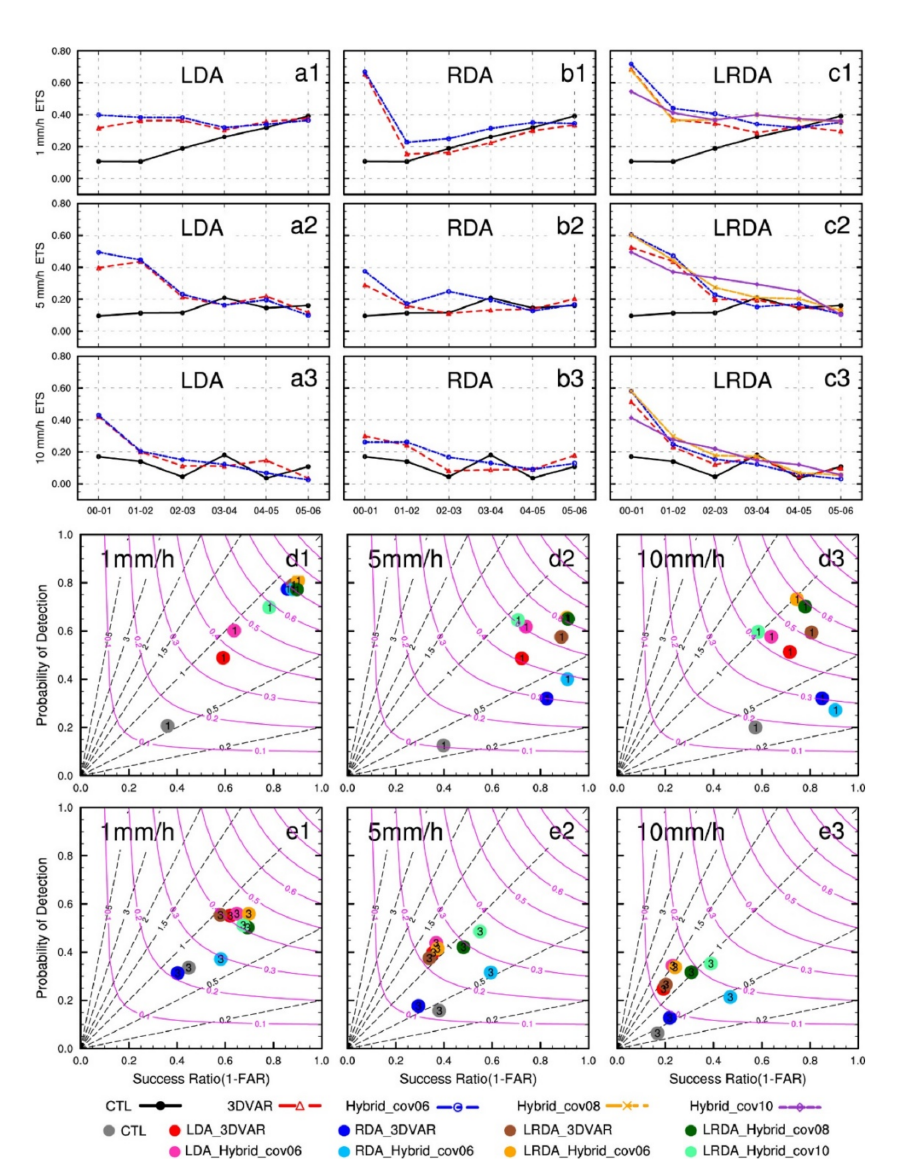
Figure 9. The equitable threat score (ETS) ( a1 – c3 ) of the forecasted hourly accumulated precipitation for single-analysis experiments from 0000 UTC to 0600 UTC on 30 June 2018. The performance diagram ( d1 – d3 , e1 – e3 ) of 1 and 3 h forecast hourly accumulated precipitation for single-analysis ex- periments from 0000 UTC to 0100 UTC and 0200 UTC to 0300 UTC on 30 June 2018. ( a1 – a3 ) The light- ning data assimilation experiments (LDA), ( b1 – b3 ) the radar data assimilation experiments (RDA), and ( c1 – c3 ) the combined lightning and radar data assimilation experiments. ( a1 , b1 , c1 , d1 , e1 ) the 1 mm threshold, ( a2 , b2 , c2 , d2 , e2 ) the 5 mm threshold, and ( a3 , b3 , c3 , d3 , e3 ) the 10 mm threshold. In each performance diagram plot, the lower-left corner represents no forecast skill and, similarly, the upper-right corner indicates perfect skill. Purple curves represent the critical success index (CSI), and the black dashed lines represent the frequency bias. The colored dots show the results for the experiments with legends shown at the bottom of the figure, the number inside each dot represents the forecast time in